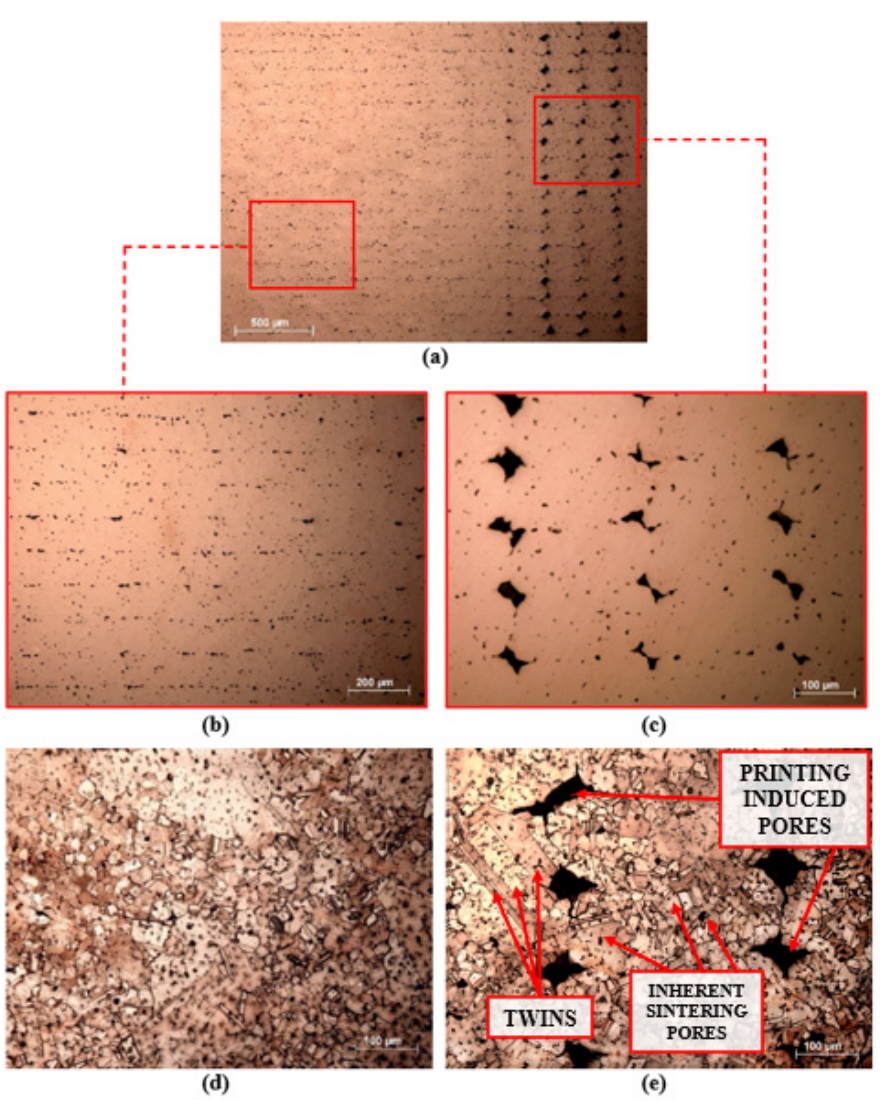
Figure 7. Cross section micrographs of sintered copper parts. ( a ) General view (×50). ( b ) Interior area with solid infill printing strategy (×200). ( c ) External perimeter with contouring printing strategy (×200). ( d ) Microstructure in interior area. ( e ) Microstructure in external perimeter.